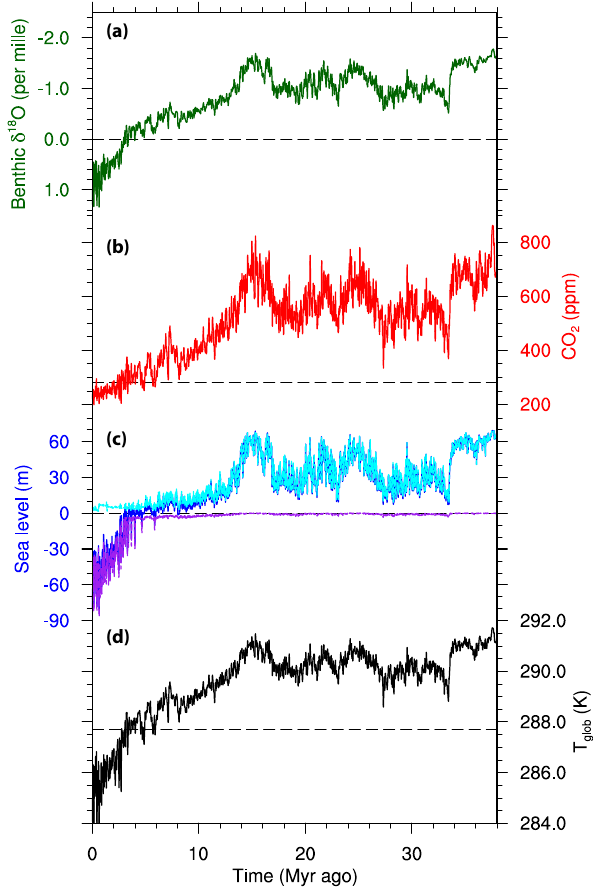
Figure 6. Results of the new reference run: (a) benthic δ 18 O, (b) at- mospheric CO 2 , (c) ice-volume-equivalent sea level in metres above present day (blue), and contributions from the Northern Hemisphere (purple) and Antarctic ice sheets (cyan). (d) Global mean tempera- ture ( T glob ); 40kyr running averages are shown. Dotted lines repre- sent pre-industrial (PI) values.